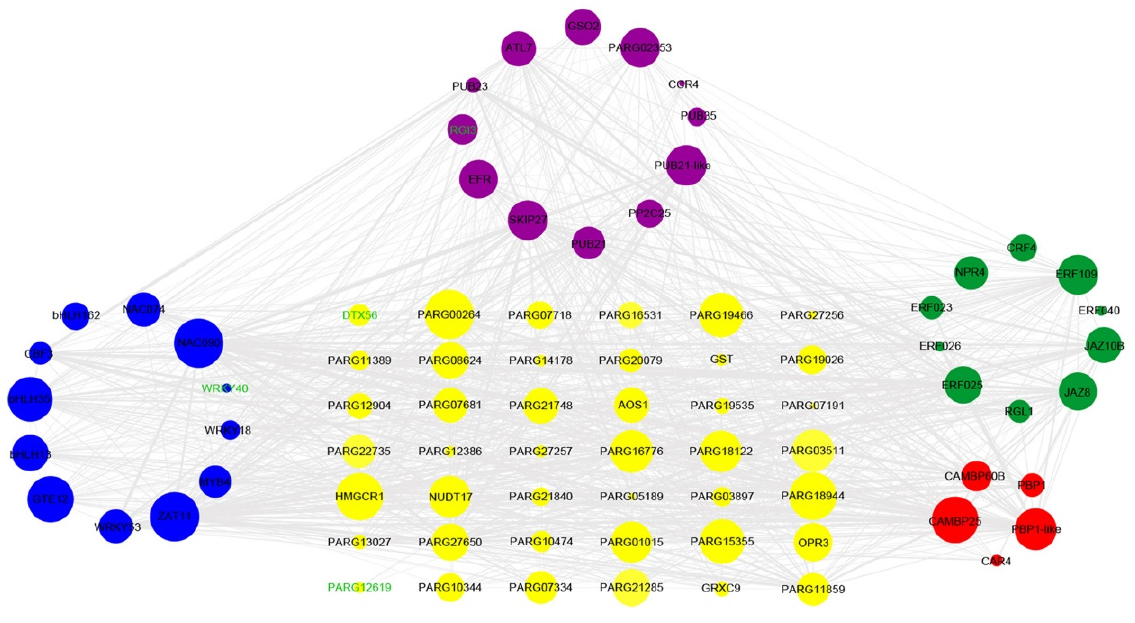
Figure 4. The co-expression network of hub genes in the magenta module. Red nodes refer to Ca 2+ -related genes; green nodes refer to genes involved in hormone signaling; purple nodes refer to genes involved in post-translational modification; blue nodes refer to TFs. Black words indicate up-regulated genes; green words indicate down-regulated genes. The size of the nodes is based on intra-modular connectivity (kME). The width of the edges is based on weight.